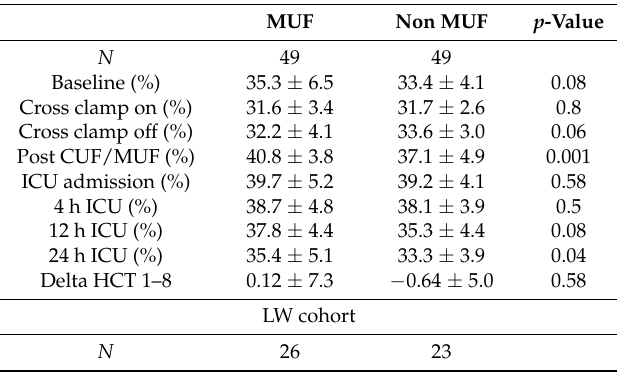
Table 3. Hematocrit